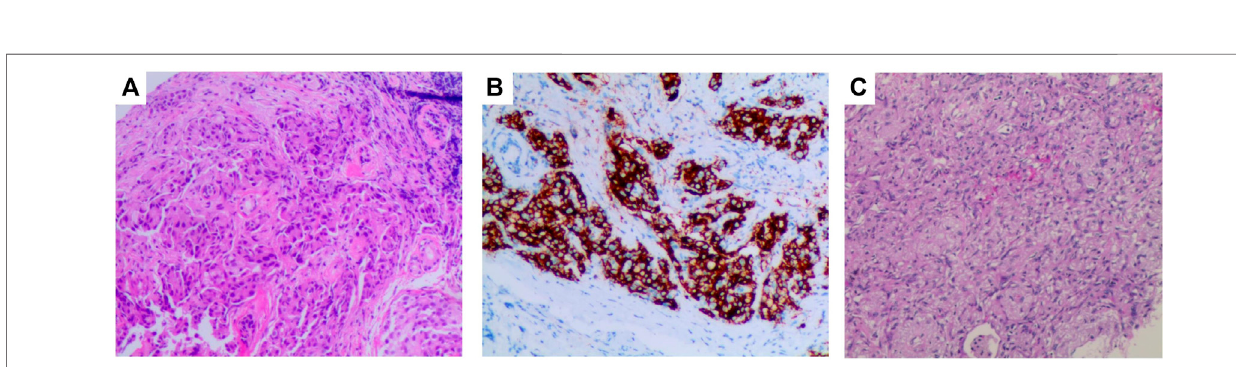
FIGURE 2 | Pathologic fi ndings of this patient. (A) , Bronchoscopic biopsy of the mass before treatment showed poorly differentiated pulmonary adenocarcinoma (H&E, × 100); (B) , Immunohistochemical testing results (D5F3 assay) con fi rmed strong positivity of ALK (× 100); (C) , Postoperative pathology showed pathological complete response, with a downstaging to ypT0N0M0 (H&E, × 100).